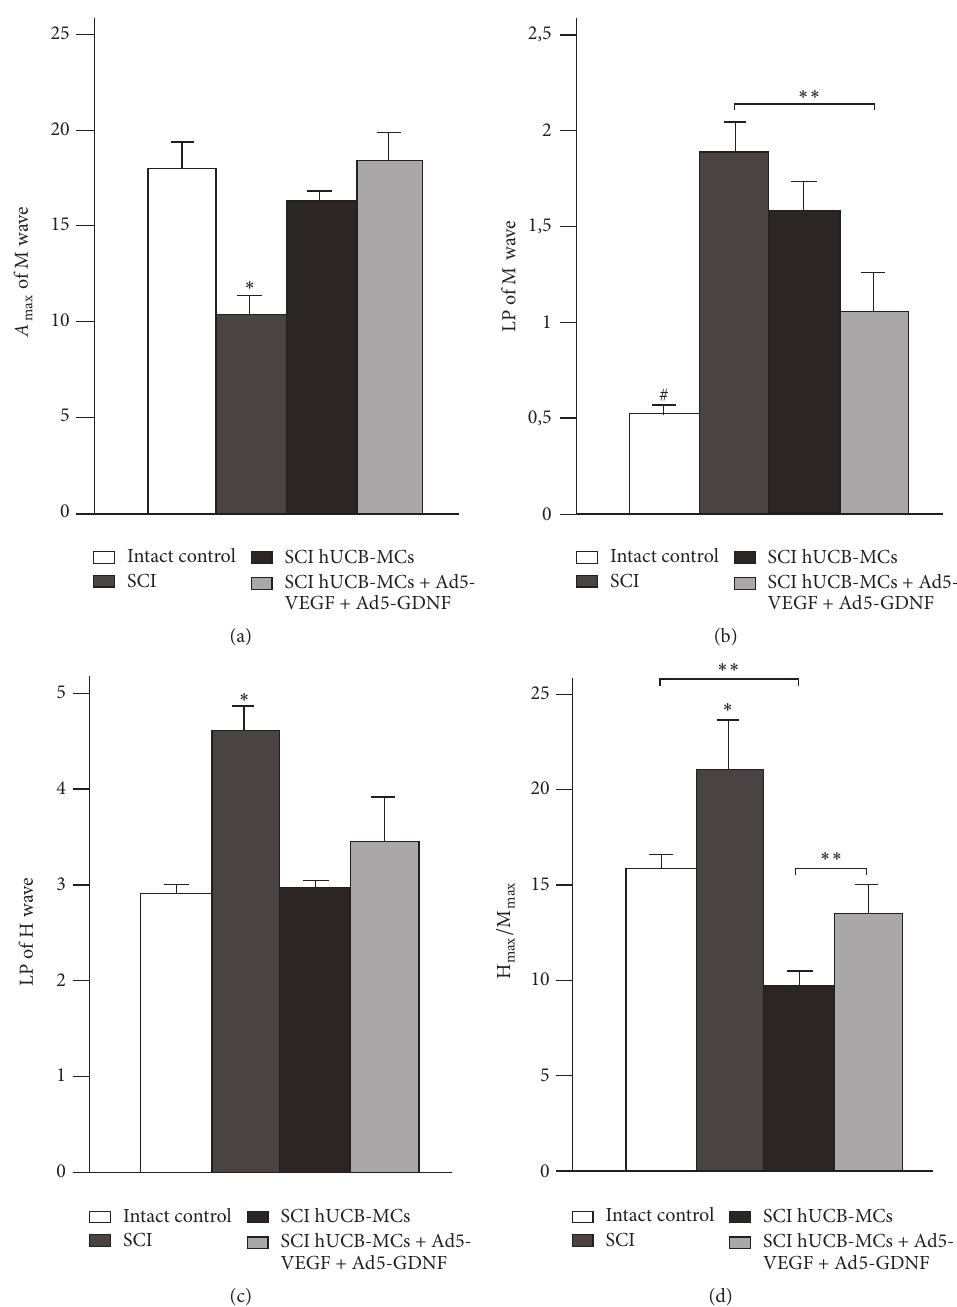
Figure 1: Electrophysiology results. 𝐴 max of M wave (a), LP of M and H wave ((b) and (c), resp.), and the ratio between H and M wave amplitudes (d) after spinal cord contusion in experimental groups. Differences were statistically significant between SCI and other experimental groups ( ∗ 𝑃 < 0.05 ). Differences were also statistically significant between intact and other experimental groups ( # 𝑃 < 0.01 ). ∗∗ 𝑃 < 0.05 , one-way ANOVA followed by a Tukey’s post hoc